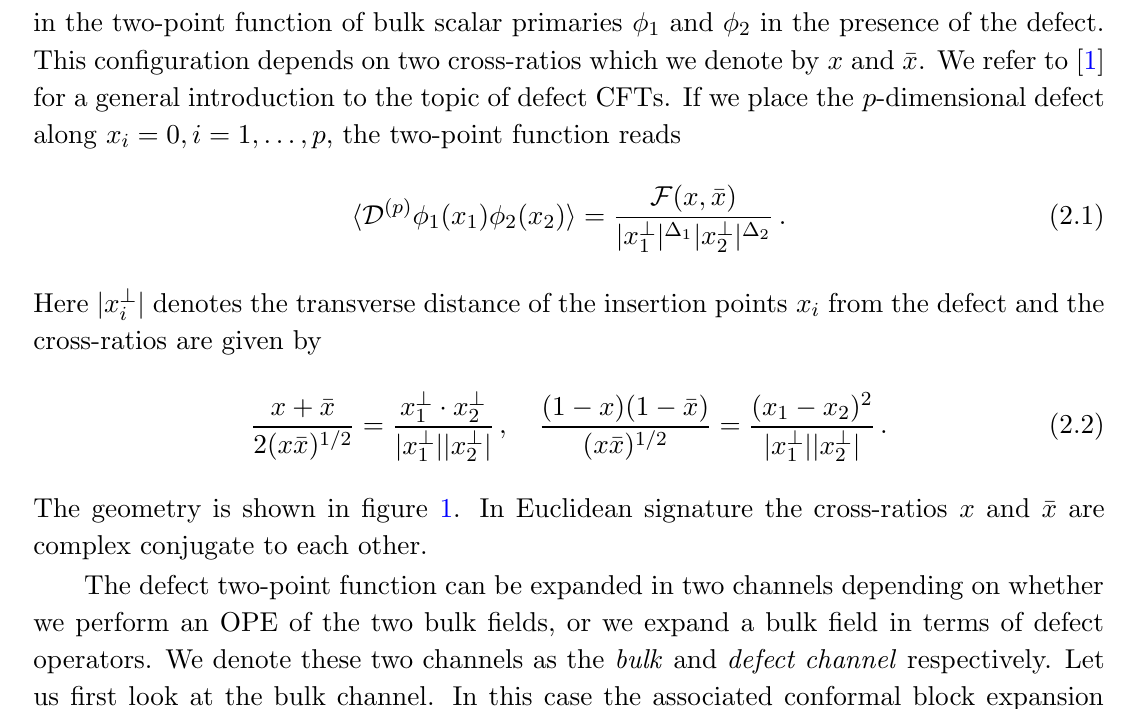
lightcone bootstrap [17, 18, 25, 26] adapted to the defect setup, and discuss some relevant inversion formulas. Euclidean inversion formulas are known for the defect [22] and bulk [3] channel, but so far a Lorentzian version was only obtained for the defect case; see [22] and our review in subsection